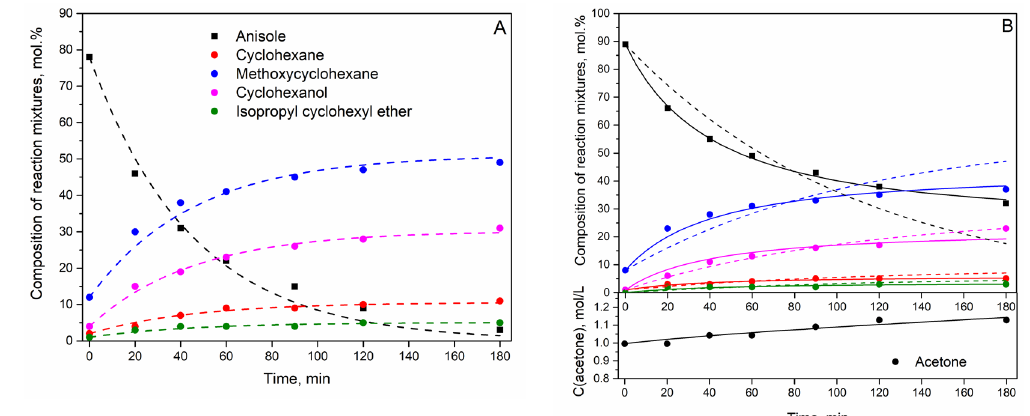
Figure 6. Percentage composition of the reaction mixtures as a function of time obtained over ( A ) Ni(36)–SiO 2 and ( B ) Ni(41)Cu(4)–SiO 2 at 250 °C, 7.3–8.1 MPa; m(catalyst) = 0.10–0.11 g; 15 mL of 2-PrOH were replaced with acetone. The dots present the experimental data and the dash lines were calculated using a quasi-first-order kinetic model. Solid lines—the model taking into account the competitive adsorption of acetone.